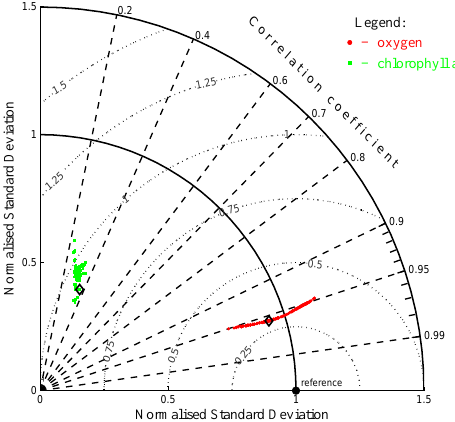
Fig. 5. Taylor diagram for the model sensitivity to limiting nutrients showing model to reference statistics for the oxygen (red) and the chlorophyll a (green) field for the period 1998–2003 at BS. The comparison points with the minimum RMSD values are indicated by a black diamond (“ ♦ ”). The ranges of the intervals in which vary the initial concentrations and surface fluxes of nutrients are given in Table 2.